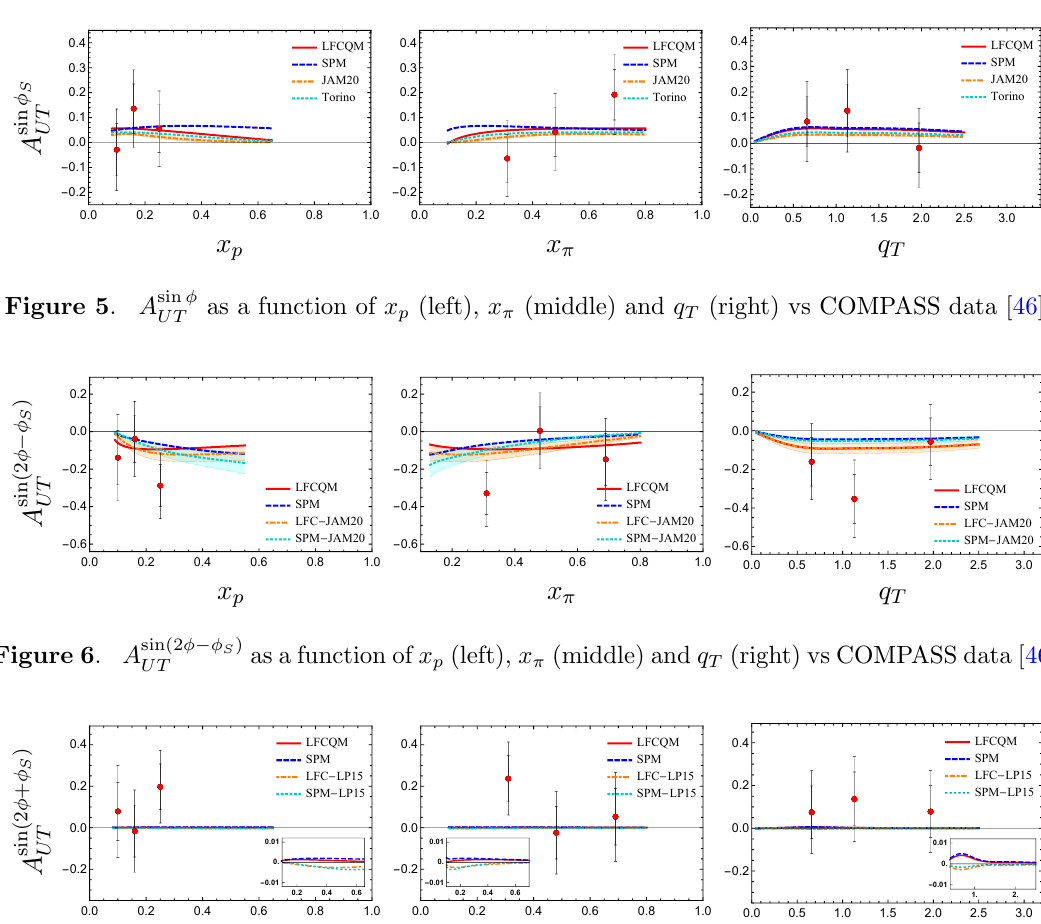
our results to COMPASS data [46]. The u -quark Sivers function in DY is expected to be positive, see (cid:12)gure 4. If we disregard sea quark e(cid:11)ects, which were shown to play a